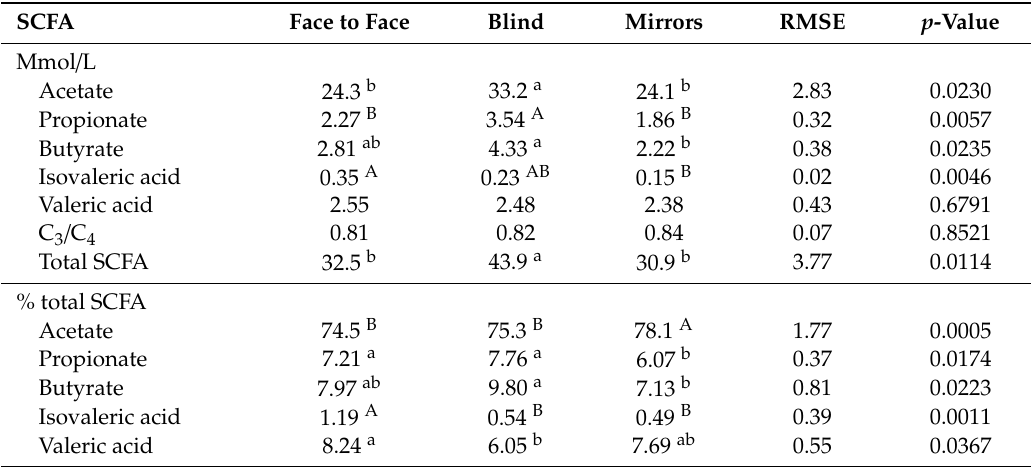
Table 9. E ff ect of housing systems on short-chain fatty acid (SCFA) production in rabbit’s caecum. SCFA Face to Face Blind Mirrors RMSE p -Value Mmol / L Acetate 24.3 b 33.2 a 24.1 b 2.83 0.0230 Propionate 2.27 B 3.54 A 1.86 B 0.32 0.0057 Butyrate 2.81 ab Isovaleric